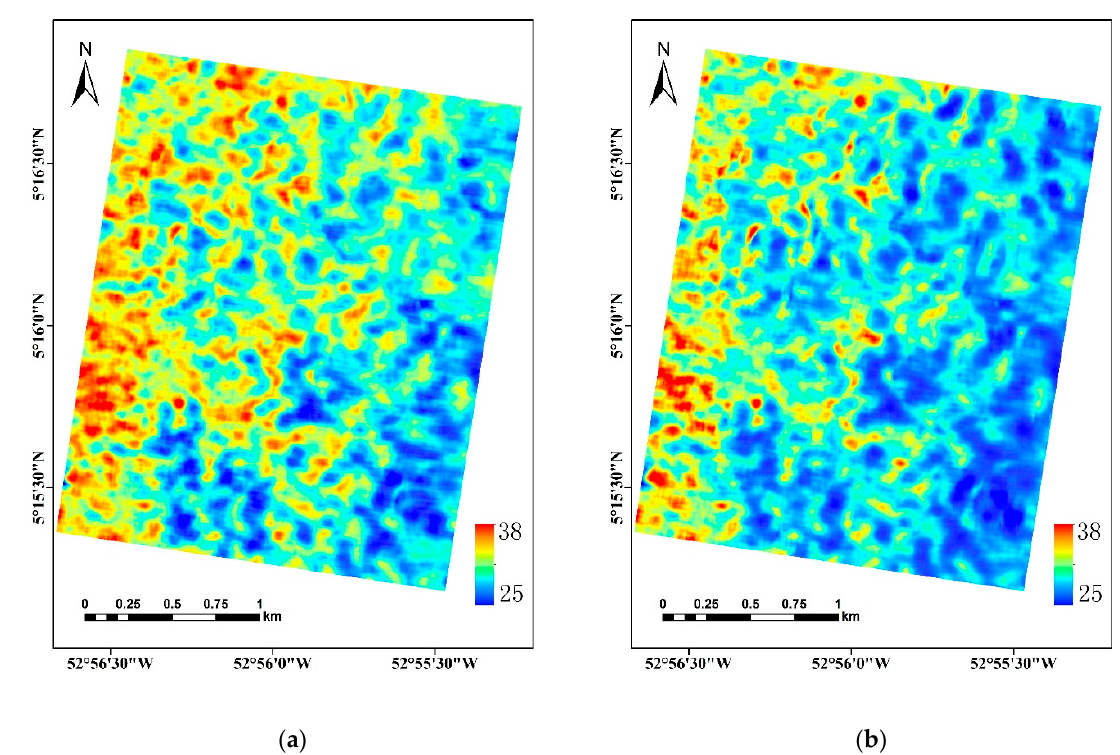
Figure 10. Backscattered power of 15m height layer. ( a ) Before terrain compensation; ( b ) after terrain compensation in the right image.